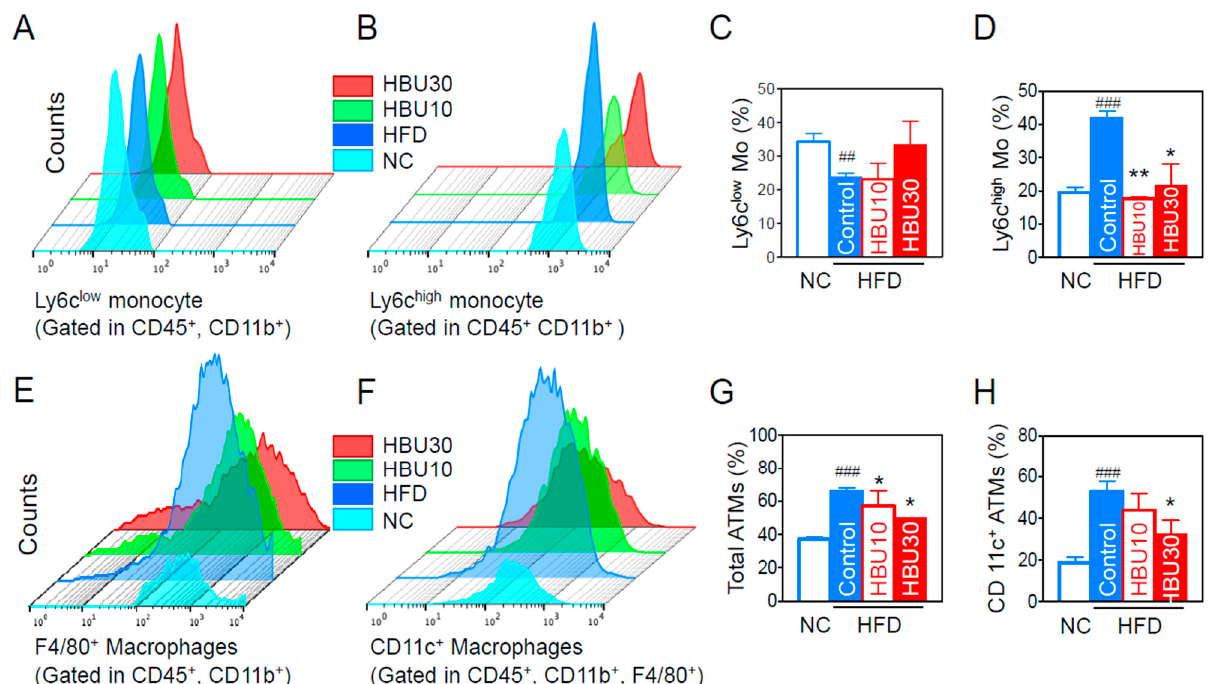
Figure 5. Effects of HBU651 on blood inflammatory monocytes and adipose tissue macrophages (ATM) in HFD-induced obese mice. ( A ) Flow cytometry of blood Ly6c low monocytes (Mo), and ( B ) blood Ly6c high monocytes, ( C ) Percentage of Ly6c low monocytes, and ( D ) Ly6c high monocytes, ( E ) Flow cytometry of CD45 + , CD11b + , and F4/80 + ATM, and ( F ) CD11c + inflammatory ATM, ( G ) Percentage of total ATMs, and ( H ) CD11c + inflammatory ATM. Data are expressed as the mean ±SEM ( n = 5). ## p < 0.01, ### p < 0.001 vs. NC, and * p < 0.05, ** p < 0.01 vs. HFD-control. NC, normal chow; Control, HFD-control; HBU10, HFD plus HBU651 10 mg/kg; HBU30, HFD plus HBU651 30 mg/kg.